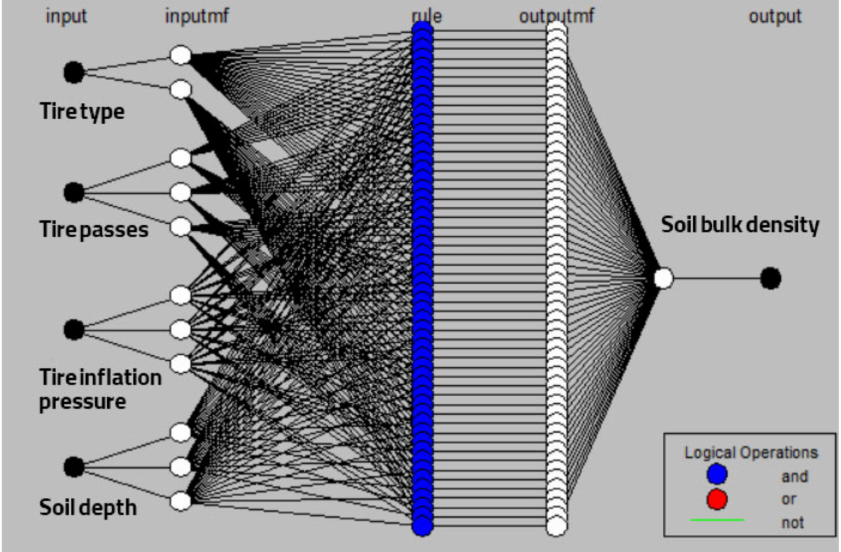
Figure 4. Structure topology of the neural-fuzzy adaptive fuzzy inference system